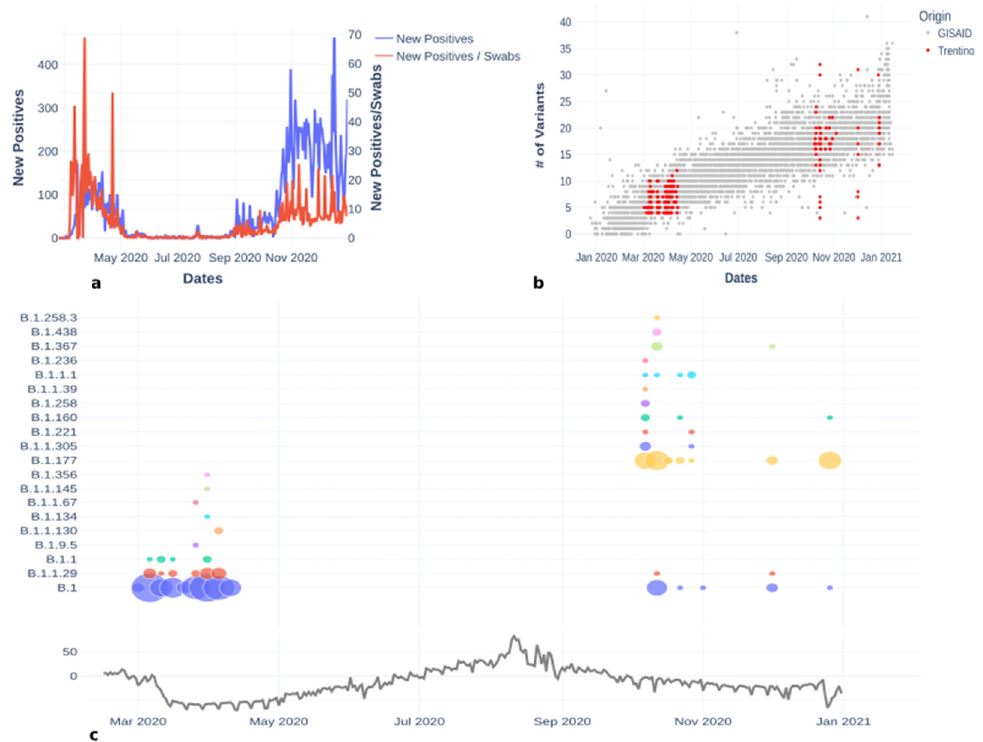
Figure 1. ( a ) The blue line represents the daily new COVID-19 positive cases in Trentino in 2020, while the red line is the percentage of positive daily swabs. The second epidemic wave is characterized by an increase in the number of tests, resulting in a reduction of the ratio between new positive cases and number of tests, but an increase of the absolute number of new positive cases. ( b ) Number of mutations compared to the Wuhan reference genome as a function of sampling date for a selection of sequences from the GISAID database and for the sequences generated in this study (red dots). ( c ) Relationship between the number of sequenced genomes classified according to the Pangolin classification scheme and mobility data monitored in Trentino. The diameter of each circle is proportional to the number of sequenced samples that belong to each lineage.